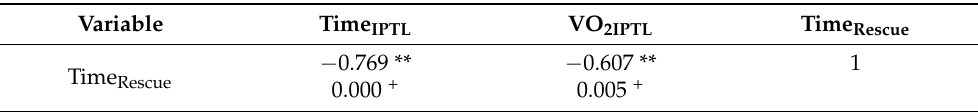
Table 5. Analysis of the correlations between the variables observed in the IPTL and the effectiveness in the